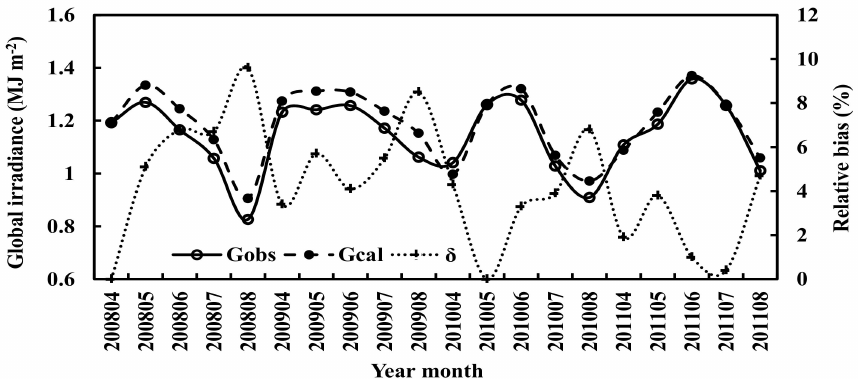
Figure 3. The observed and calculated monthly averages of hourly global solar irradiance (G obs and G cal ) and relative biases ( δ ) in all sky conditions at Sodankylä.